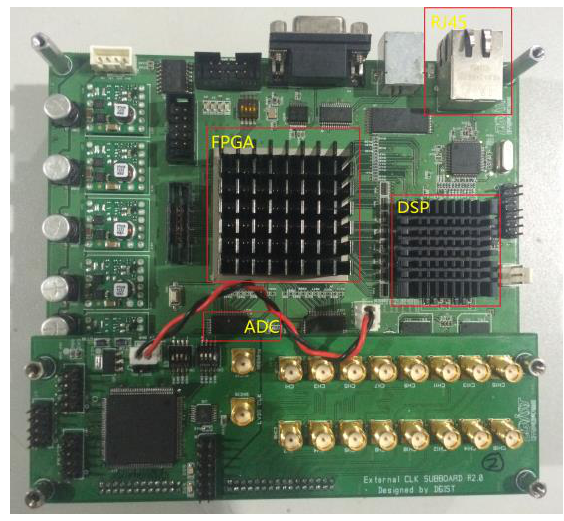
Figure 10. FPGA and DSP board.